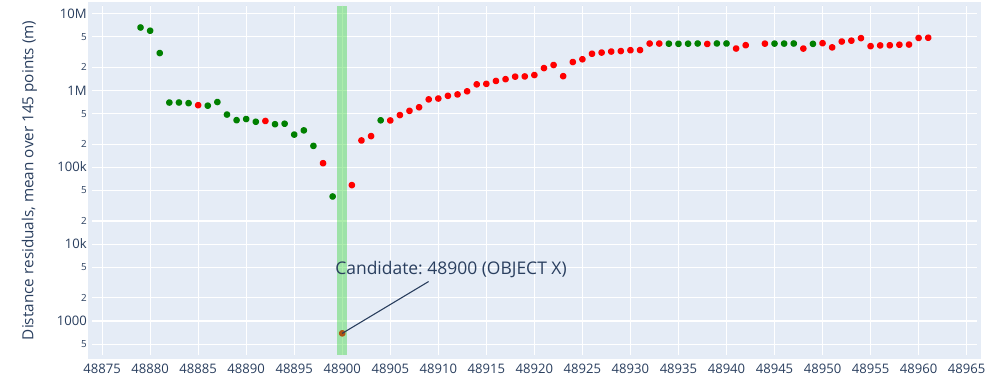
Figure 5. Mean position residuals (log scale) between the TLE of each cataloged object in launch and GPS measurements from TUBIN. TLE are from 9 July 2021 at 12:00 a.m. UTC. A green dot means the corresponding spacecraft was already identified on Space-Track at that time, and a red dot means